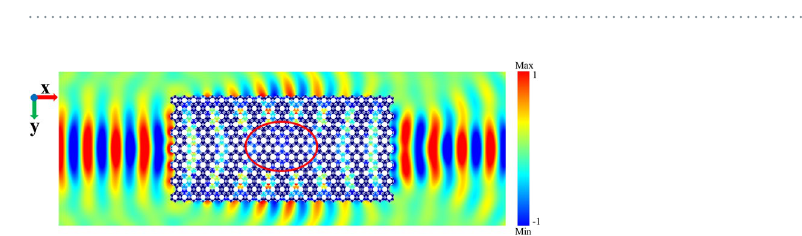
Figure 3. The self-focusing of the GRIN slab at the frequency of 25 kHz.